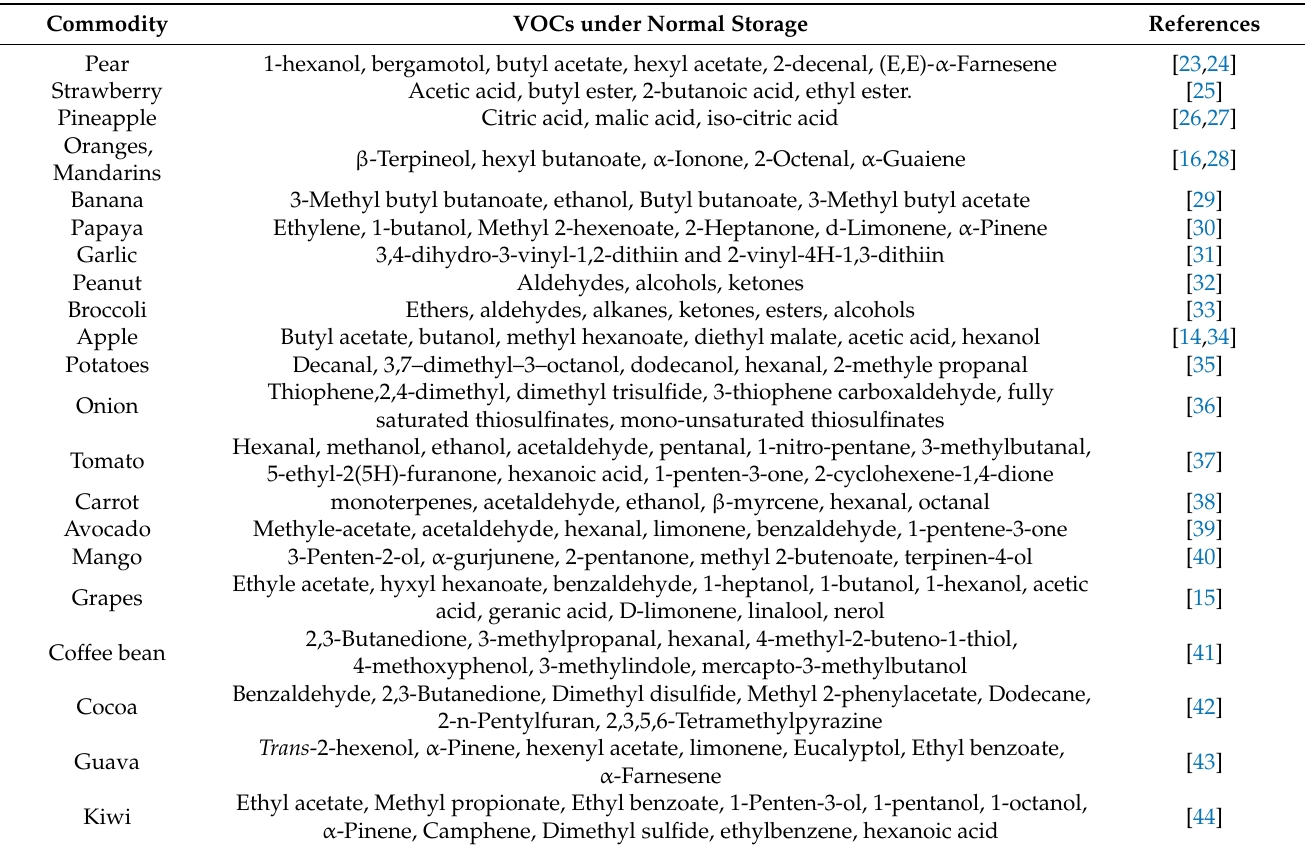
Table 1. Volatile fingerprints of food products for quality